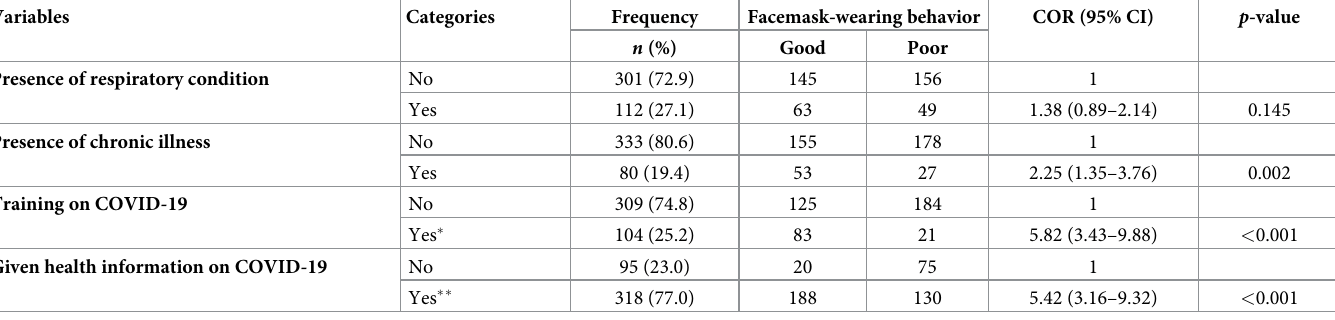
Table 5. Medical history-related and COVID-19 source-of-information factors and bivariable analysis with facemask-wearing behaviors among bank workers in Dessie City, Ethiopia, January 2021. Variables